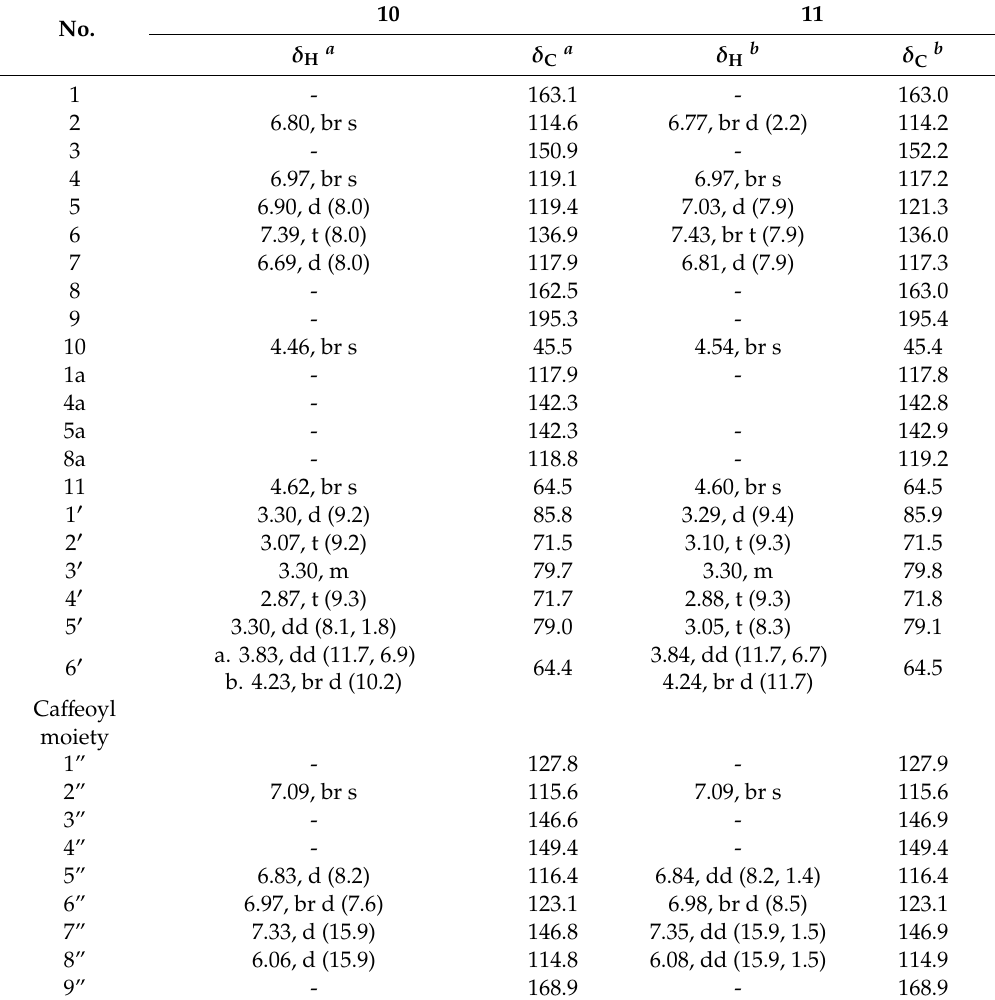
Table 2. 1 H (500 MHz) and 13 C NMR (125 MHz) spectroscopic data in CD 3 OD for compounds 10 and 11 .